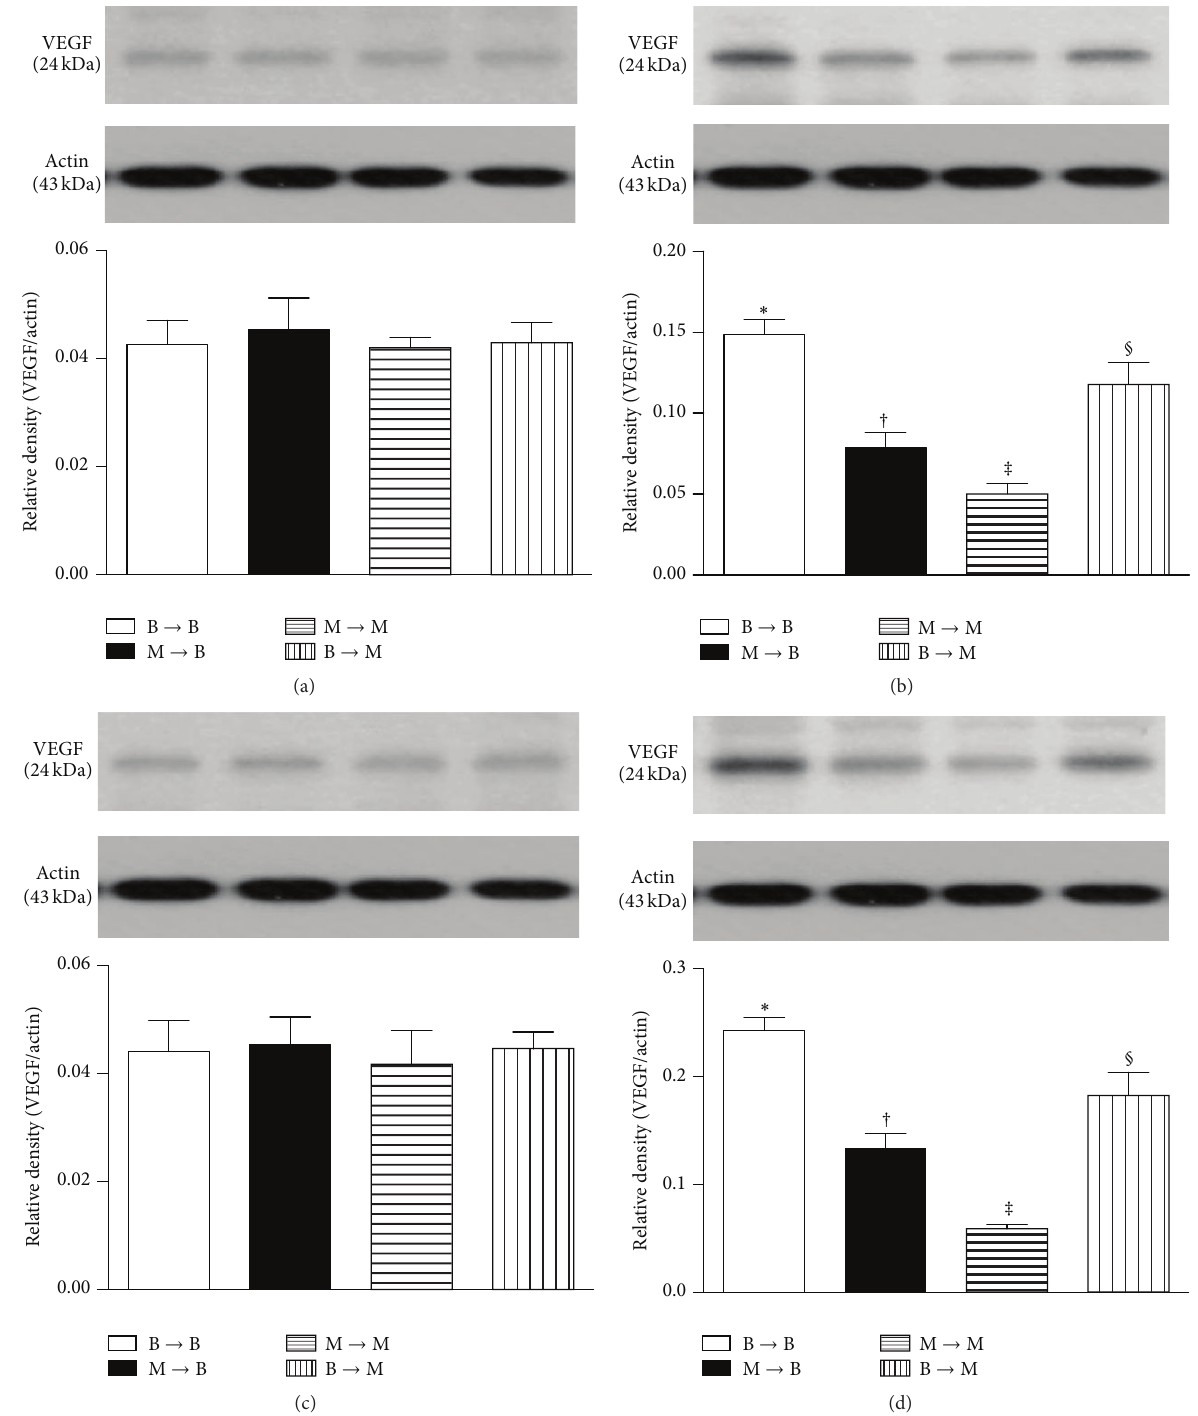
Figure 11: Protein expression of vascular endothelial growth factor (VEGF) in ischemic quadriceps at day 14 after critical limb ischemia (CLI) induction. (a) At sham control (SC) treatment condition, VEGF did not differ among four groups, 𝑝 = 1.0 . (b) At CLI subgroup, groups with different symbols ( ∗ , † , ‡ , and §), 𝑝 < 0.05 . (c) At SC + tPA subgroup, VEGF did not differ among four groups, 𝑝 = 1.0 . (d) At CLI + tPA subgroup, groups with different symbols ( ∗ , † , ‡ , and §), 𝑝 < 0.05 . All statistical analyses were performed by one-way ANOVA followed by Bonferroni multiple comparison post hoc test. tPA = tissue plasminogen activator. 𝑛 = 6 for each